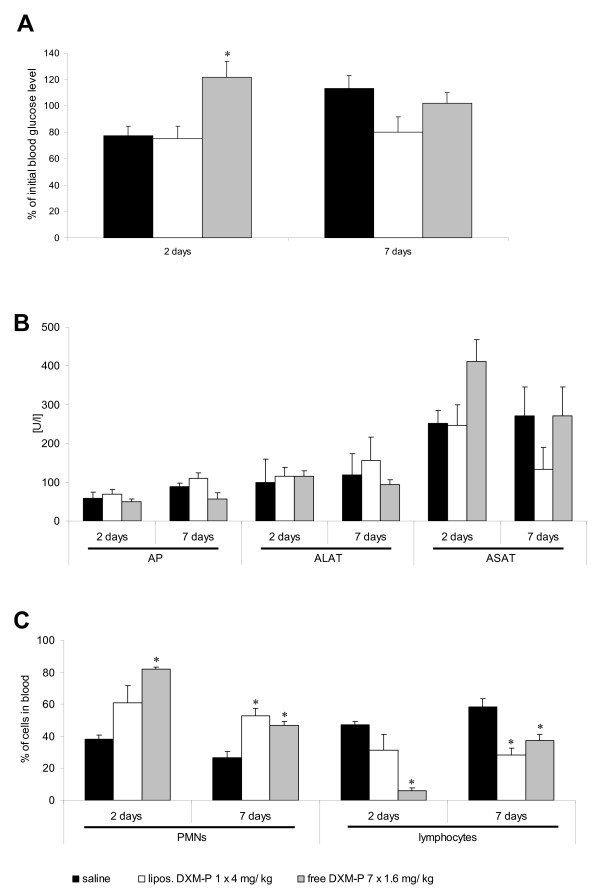
Effects of liposomal and free dexamethasone phosphate on blood glucose, liver enzymes and haematology. (a) Glucose levels as a percentage of the initial blood value in arthritic animals following treatment with liposomal dexamethasone phosphate (DXM-P), free DXM-P, or saline. (b) Values of liver enzymes alkaline phosphatase (AP), alanine aminotransferase (ALAT) and aspartate aminotransferase (ASAT) after treatment with liposomal DXM-P, free DXM-P, or saline. (c) Percentage of polymorphonuclear neutrophilic leukocytes (PMNs) and lymphocytes in the blood of arthritic animals following treatment with liposomal DXM-P, free DXM-P, or saline. *P ≤ 0.05 Mann-Whitney U test versus saline-treated inflamed animals. n = 6 for all groups; mean ± standard error of the mean.